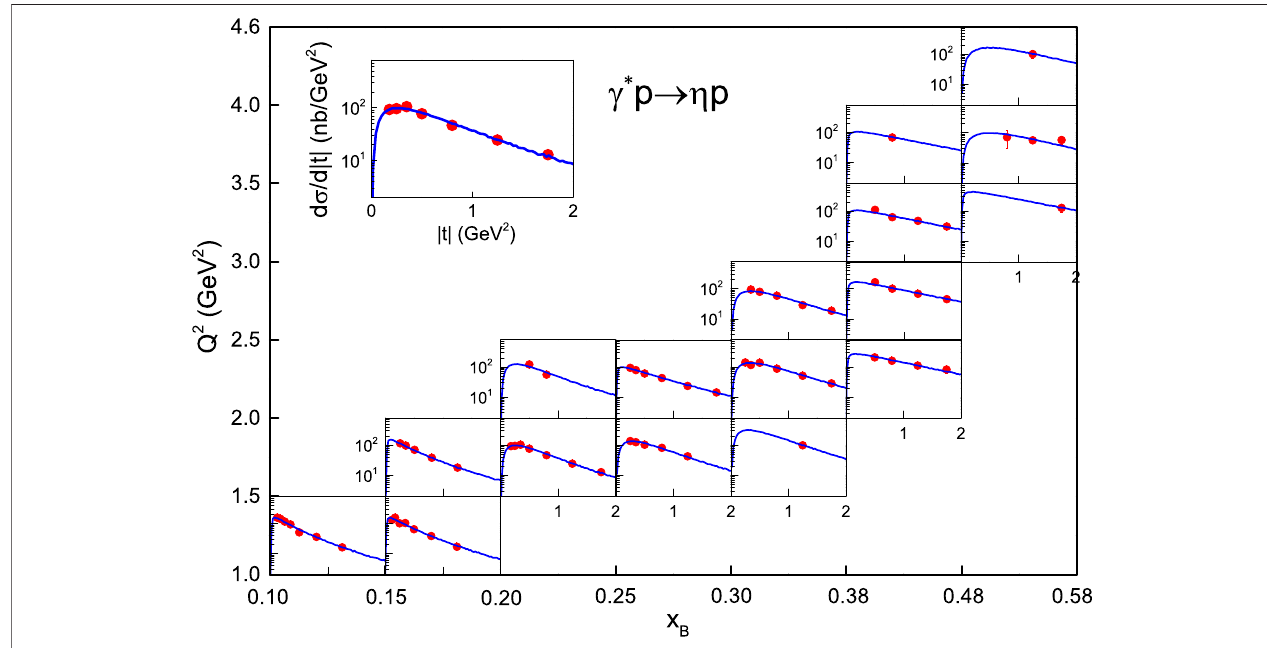
FIGURE 3 | The differential cross-section d σ / d | t | in | t | of c * p → η p process produced in ep collisions at beam energy of 5.75 GeV in different Q 2 and x B ranges showninthepanels.Asanexample,thesampleatthetop-leftsub-panelshowsrepeatedlytheresultin1.5 < Q 2 < 2.0 GeV 2 and0.20 < x B < 0.25.Thesymbolsrepresent the experimental data measured by the CLAS Collaboration [39] and the curves are the statistical results obtained as those in Figure 1 .